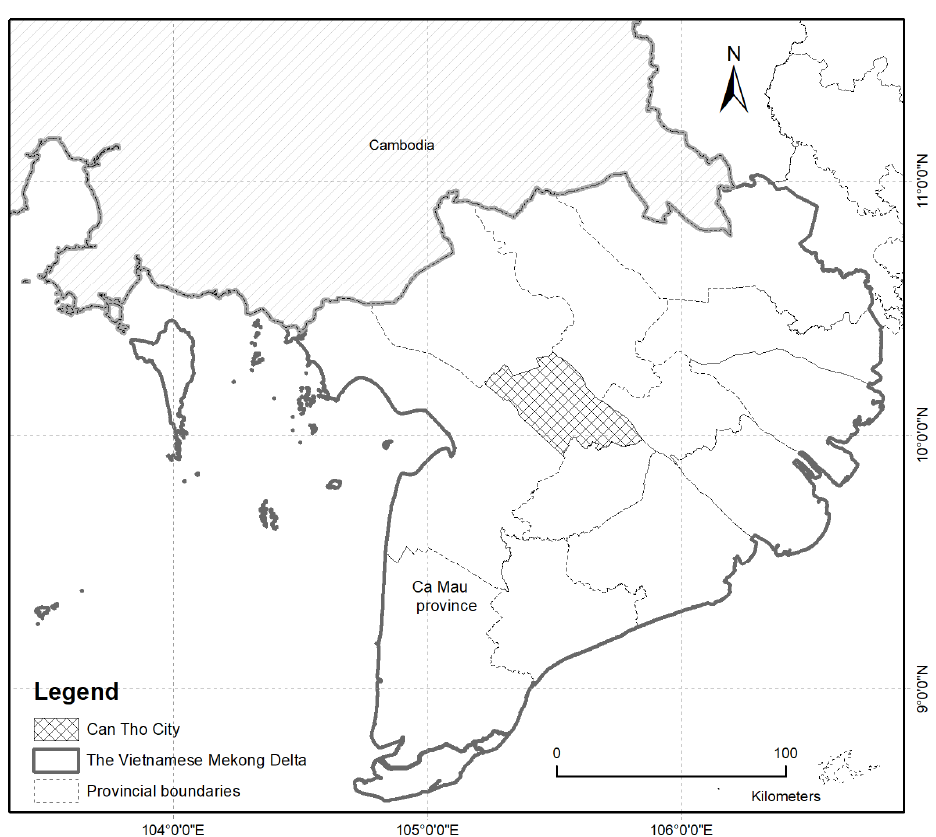
Figure 1. Location of Can Tho City and Ca Mau province, in the Vietnamese Mekong Delta.